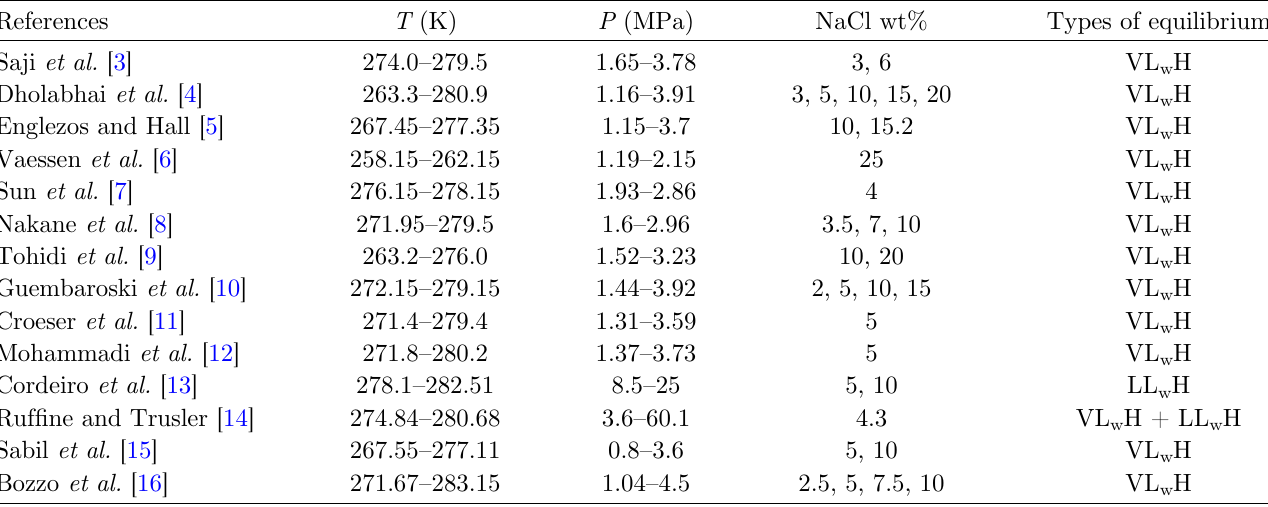
Table 1. Literature data for hydrate equilibria of CO – Hydrate / LL H: Liquid – Liquid (aqueous) – Hydrate). w